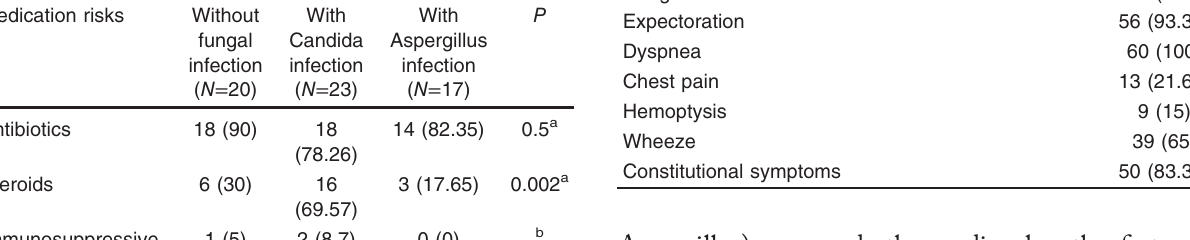
Table 4 Impact of medication used with fungal infection Medication risks